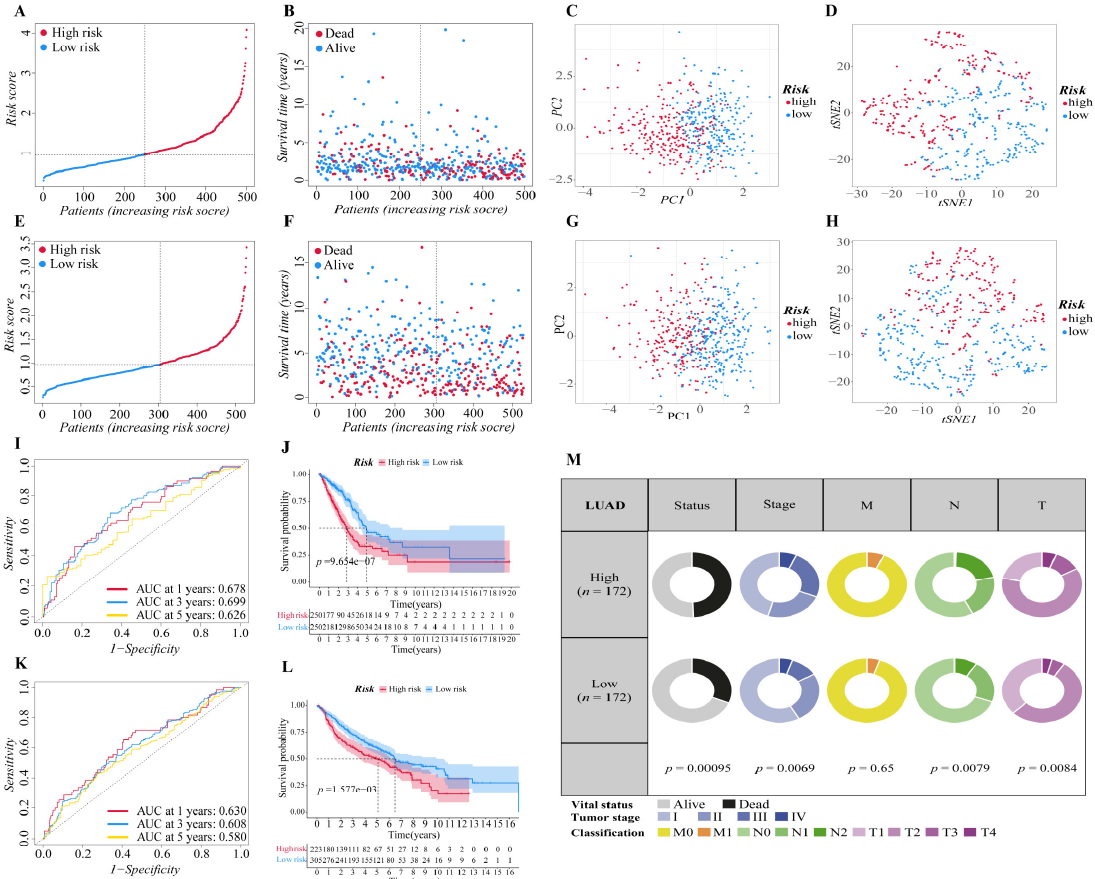
Figure 2. Validation of the six-gene signature in two cohorts. ( A , E ) The distribution and median value of the risk scores in two cohorts (( A ): training cohort; ( E ): validation cohort). ( B , F ) The distributions of survival status, overall survival time and risk score (( B ): training cohort; ( F ): validation cohort). ( C , G ) Principal component analysis (PCA) of two cohorts (( C ): training cohort; ( G ): valida- tion cohort). ( D , H ) t-SNE analysis of two cohorts (( D ): training cohort; ( H ): validation cohort). ( I , K ) ROC curve analysis shows the prognostic prediction efficiency of the signature (( I ): training cohort; ( K ): validation cohort). ( J , L ) Kaplan–Meier curves for the OS of patients in the high- and low-risk groups of two cohorts (( J ): training cohort; ( L ): validation cohort). ( M ) Pie charts showing the Chi- squared test of clinicopathologic factors in LUAD tumor samples from the TCGA.